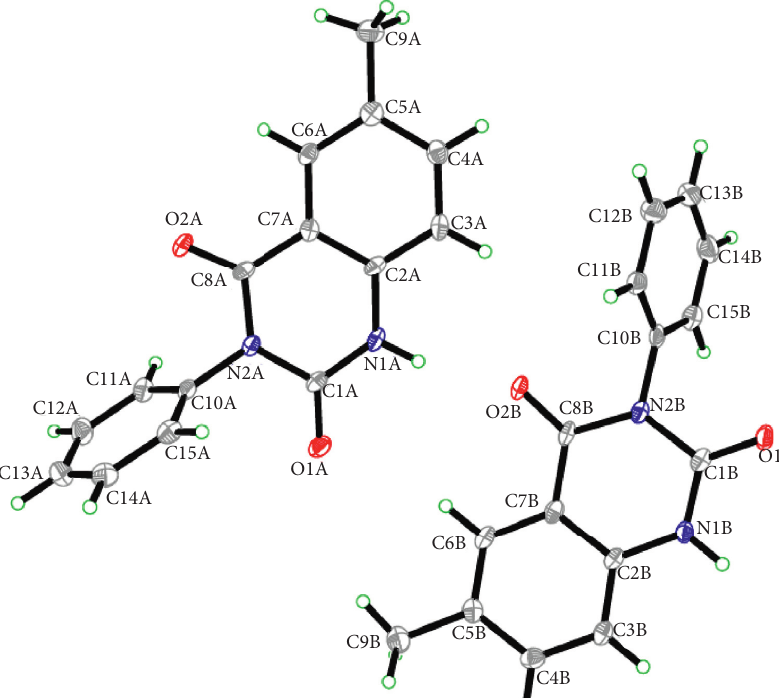
Figure 1: The ORTEP drawing of the basic crystallographic unit of 6-methyl-3-phenylquinazoline-2,4(1H,3H)-dione ( 11 ), showing the atom-numbering scheme. Displacement ellipsoids are drawn at the 40% probability level, and all H atoms are shown as small spheres of arbitrary radii.